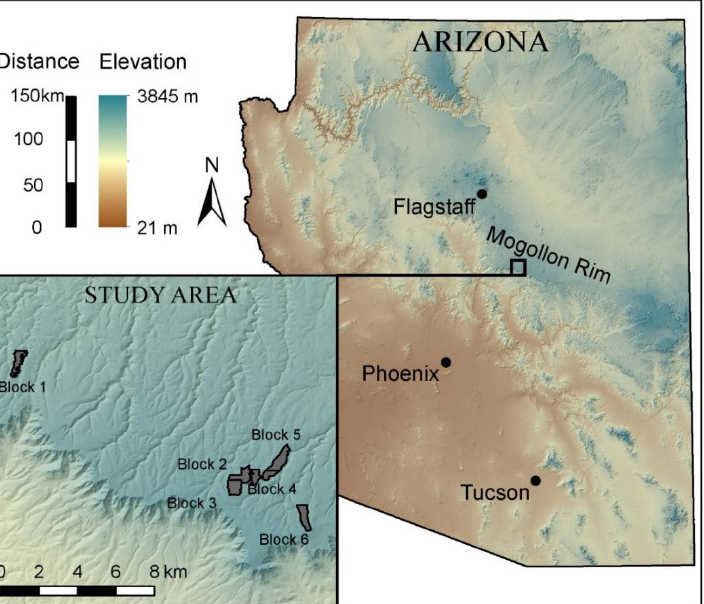
Figure 1. Map of study area. Points represent the location of selected major cities, and colors ranging from brown to blue represent low to high elevations. The Mogollon Rim is located southeast of Flagstaff. The study area on the Mogollon Rim (inset) is arranged into six blocks.